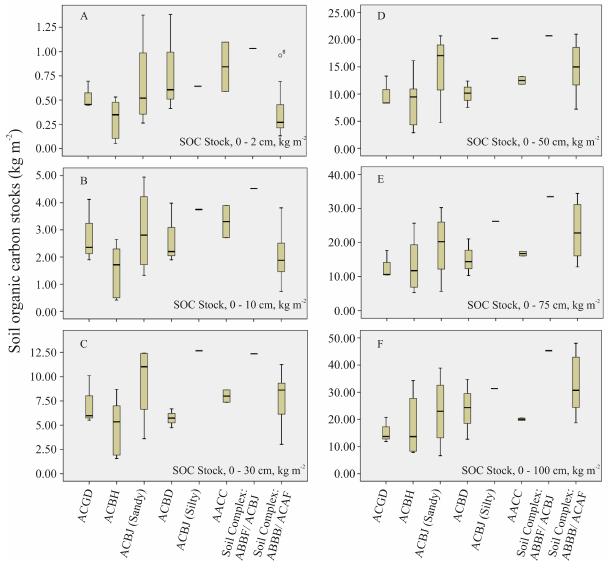
Fig. 8. Soil organic carbon stocks (kgm − 2 ) of the soil subgroups identified on Samoylov Island according to the US Soil Taxon- omy (Soil Survey Staff, 2010) for different reference depths h r . (A) h r = 2cm; (B) h r = 10cm; (C) h r = 30cm; (D) h r = 50cm; (E) h r = 75cm; (F) h r = 100cm. Note different scale for y-axis on all graphs. For acronyms along x-axis see Fig.